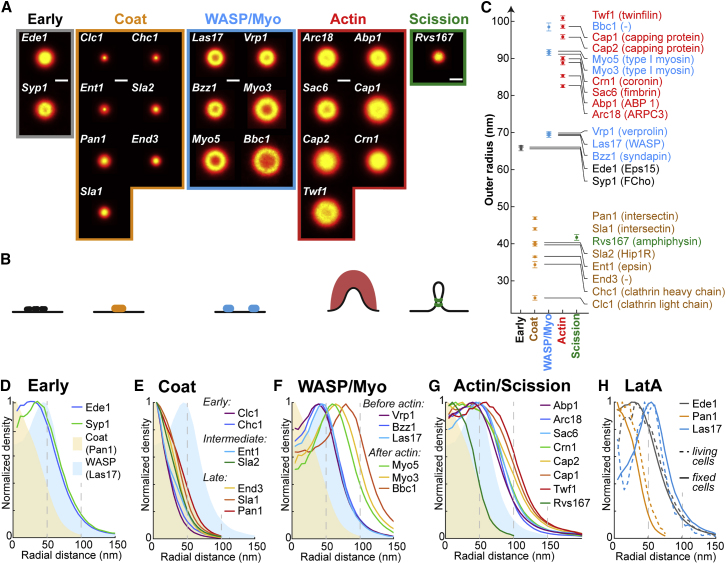
Average Radial Distribution of 23 Proteins in the Endocytic Machinery(A) Endocytic proteins form very diverse structures. Shown are the average images for 23 endocytic proteins (for a description, see text).(B) Side-view schematic of structures formed by the endocytic modules on the plasma membrane.(C) Outer radii of structures of 23 endocytic proteins (mean ± SEM; number of sites and SD in Table S1). Mammalian homologs in parentheses, as identified in Weinberg and Drubin (2012).(D–G) Average radial profiles of endocytic proteins in the early (D), coat (E), WASP (F), and actin (G) modules. Shaded areas indicate the endocytic coat (beige, profile of Pan1) and WASP modules (blue, profile of Las17).(H) Average radial profiles of Ede1, Pan1, and Las17 after LatA treatment, analyzed both in living and in fixed cells.Scale bars represent 100 nm.See Figures S1, S2, S3, and S4 for representative images of all proteins.